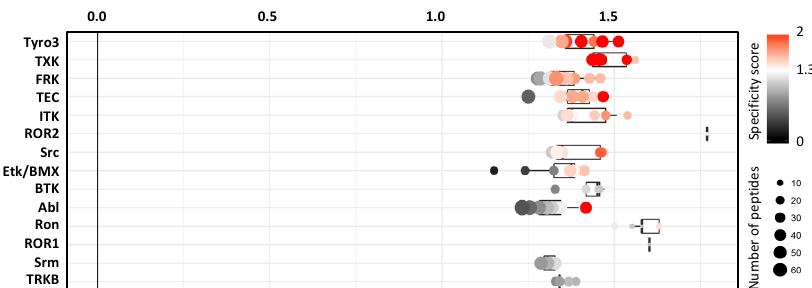
Figure 2. The prediction of SRI in TH and TC tissue samples and an RTK upstream prediction. ( a ) Unsupervised hierarchical clustering of sunitinib response ratios of 10 TC (c1–c10). ( b ) Predicted sunitinib response of TC based on their SRI (waterfall plot). Green = responding SRI, orange = resistant SRI. ( c ) Prediction of active upstream tyrosine kinases in TC. ( d ) Unsupervised hierarchical clustering of sunitinib response ratios of 19 TH samples (t1–t19). ( e ) Predicted SRI Waterfall plot on the 19 TH. ( f ) Prediction of active upstream tyrosine kinases in TH. The value on the x-axis indicates the activity change of each kinase relative to untreated control. The color indicates the reliability of the prediction (specificity score). The dot size indicates the number of phosphorylated peptides on which the prediction was